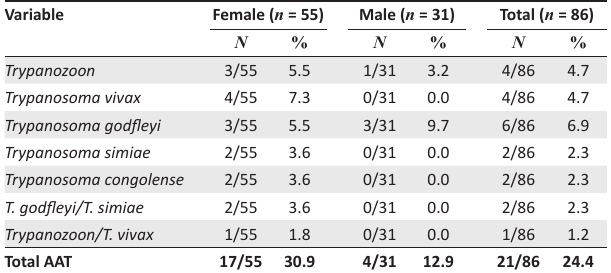
TABLE 3: Detection of trypanosome deoxyribonucleic acid by internal transcribed spacer 1-polymerase chain reaction, in Glossina morsitans morsitans from Liwonde.